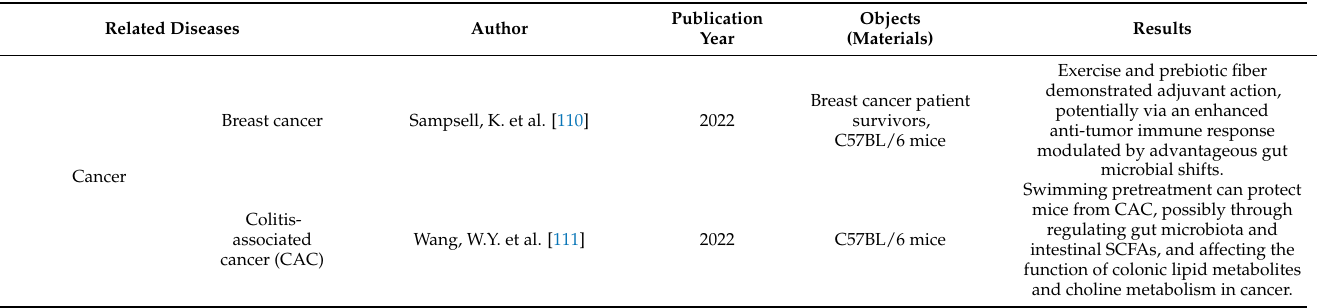
Table 8. Advances in the relationship between exercise, the gut microbiome, and